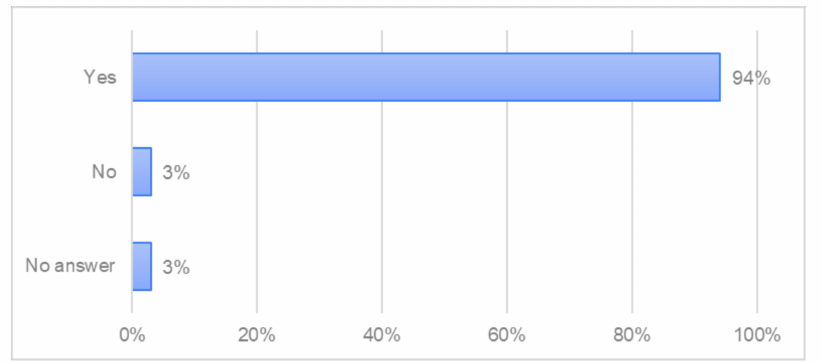
Figure 17. First aid kit at the ground workplace.